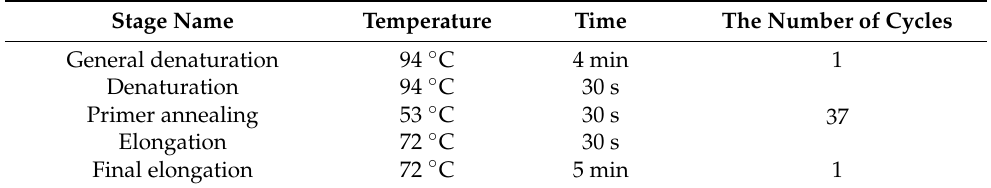
Table 2. The PCR protocol for amplification of the V3 hypervariable region of the 16S rRNA